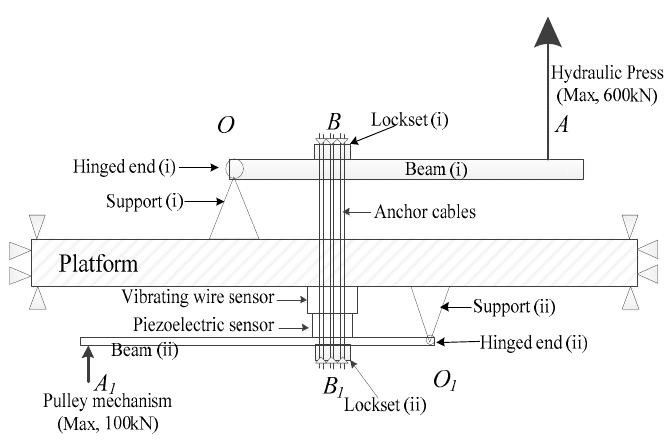
Figure 13. Schematic of the static and transient loading mechanism. Sensors 2017 , 17 , 394